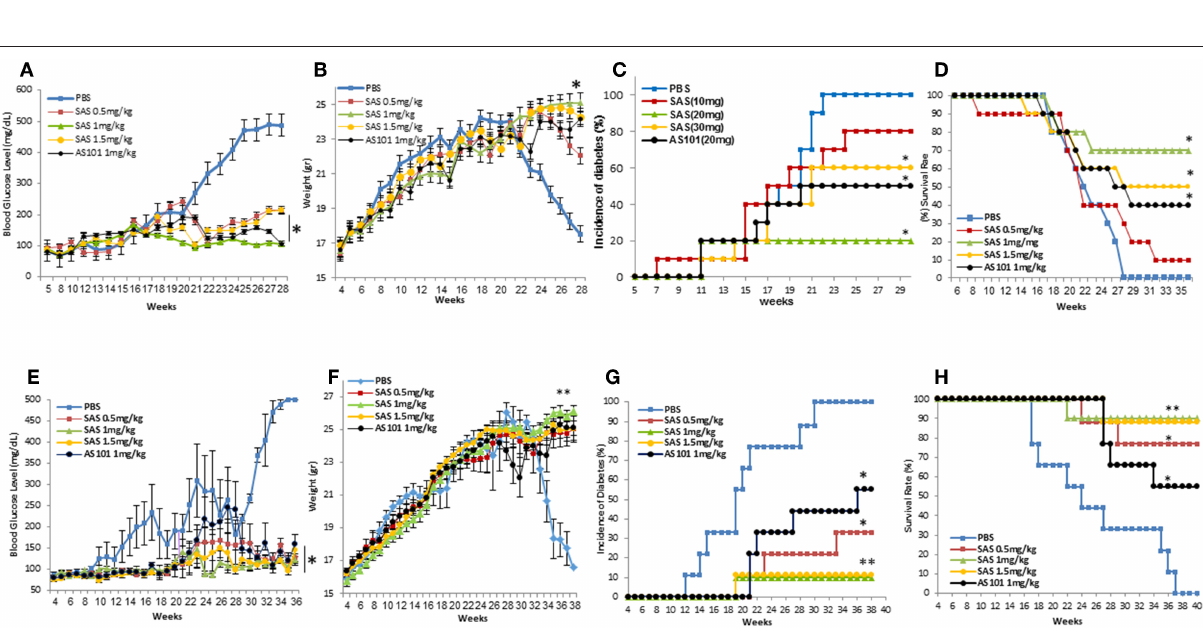
Frontiers in Immunology |